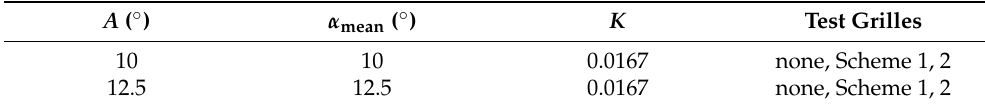
Table 2. Pressure measurement